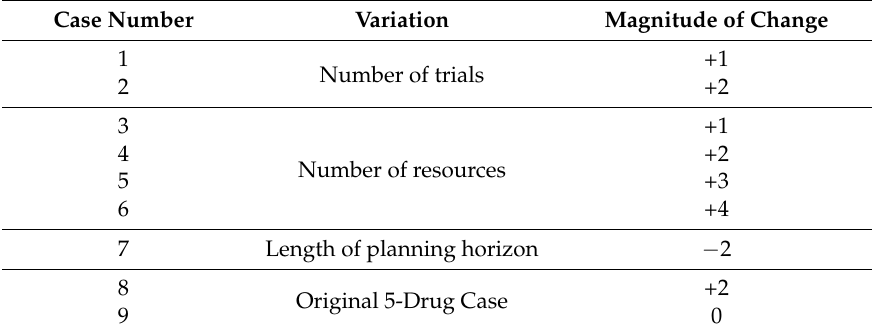
Table 4. Size perturbation cases and file names with variation